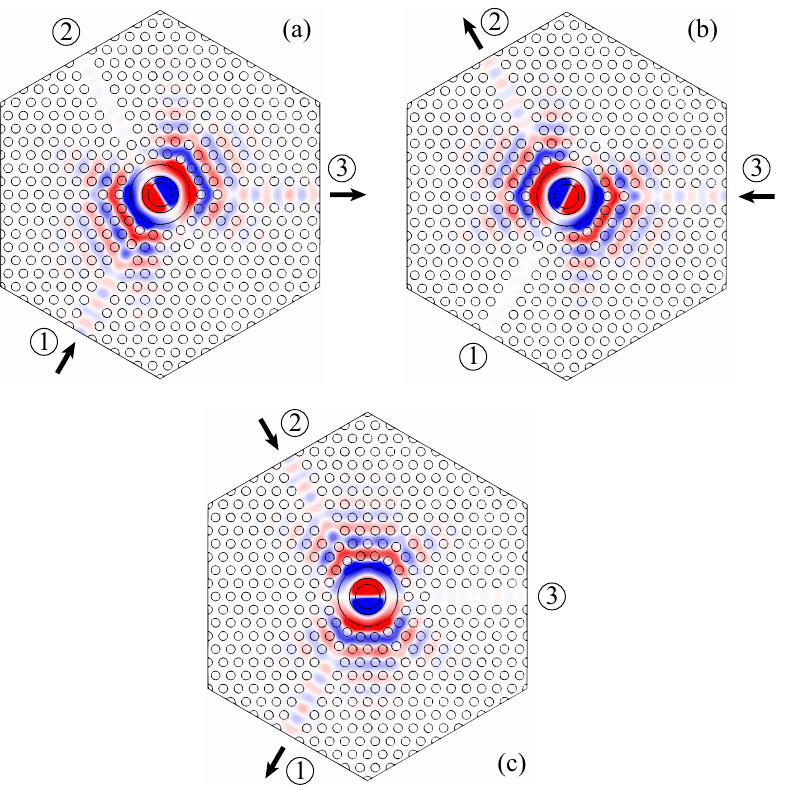
Figure 7. H z distribution at the center frequency f 0 obtained from 2D simulations performed with COMSOL Multiphysics for excitation at ( a ) port 1, ( b ) port 3, and ( c ) port 2. The calculated insertion loss, isolation, and reflection levels at the center frequency f 0 = 193.4028 THz (corresponding to λ 0 = 1550.094 nm) are − 1 dB, − 18 dB, and − 26 dB, respectively. The lower and upper frequency limits of the circulator band (highlighted in yellow in Figure 6), defined at the levels − 3 dB of the S 31 curve and − 10 dB of the S 21 and S 11 curves, are f 1 = 193.4003 THz and f 2 = 193.4053 THz, respectively. The